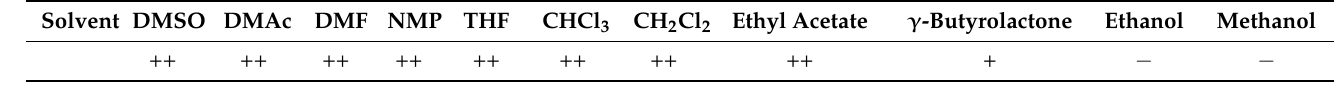
Table 1. Solubility data of the 6FDA-DPEDBA